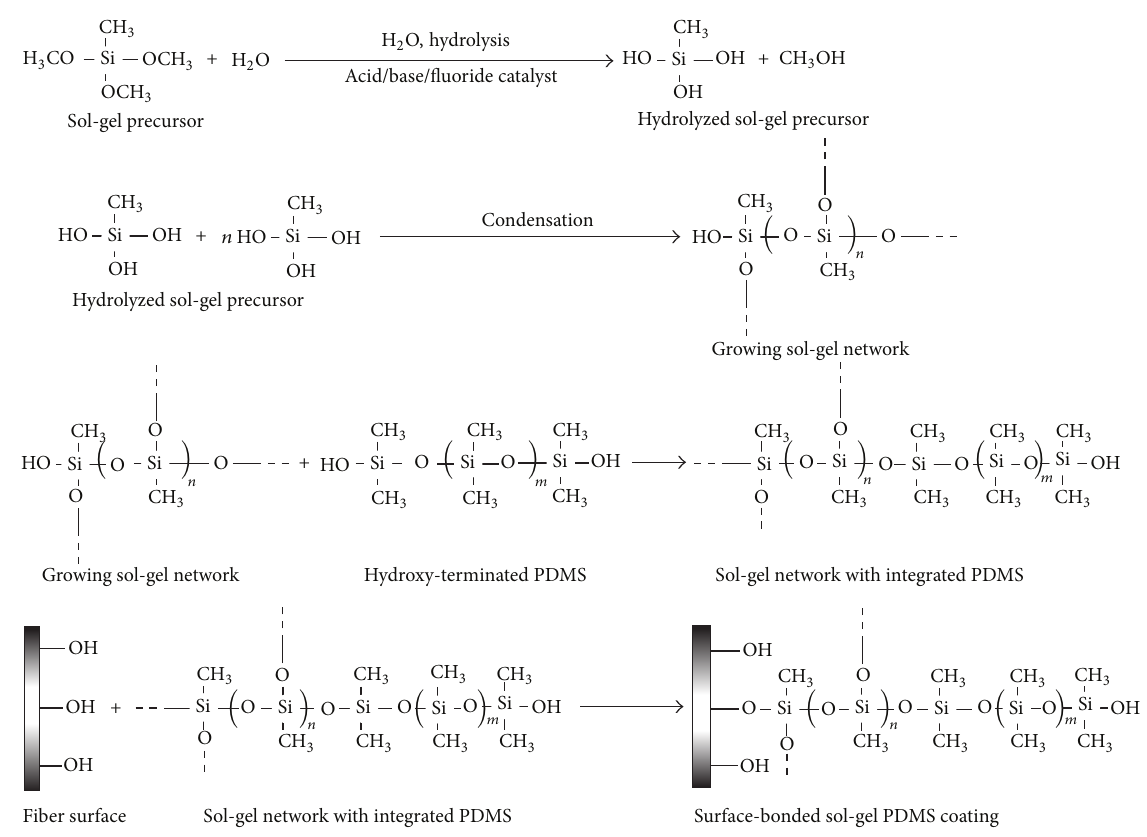
Figure 10: Chemical reactions involved in the synthesis of surface-bonded sol-gel hybrid organic-inorganic polymeric network